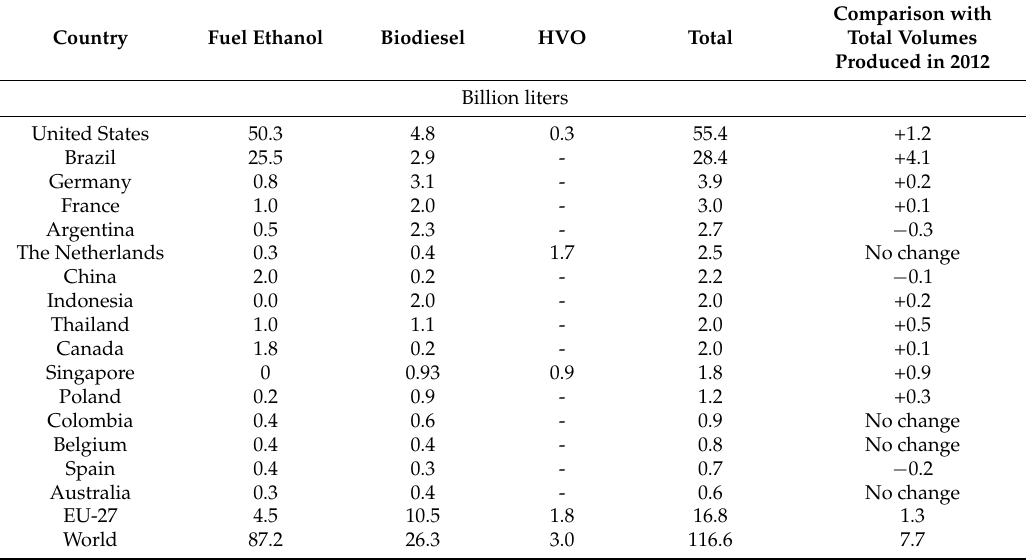
Table 1. Bio-fuels global production (top 16 countries and EU-27),